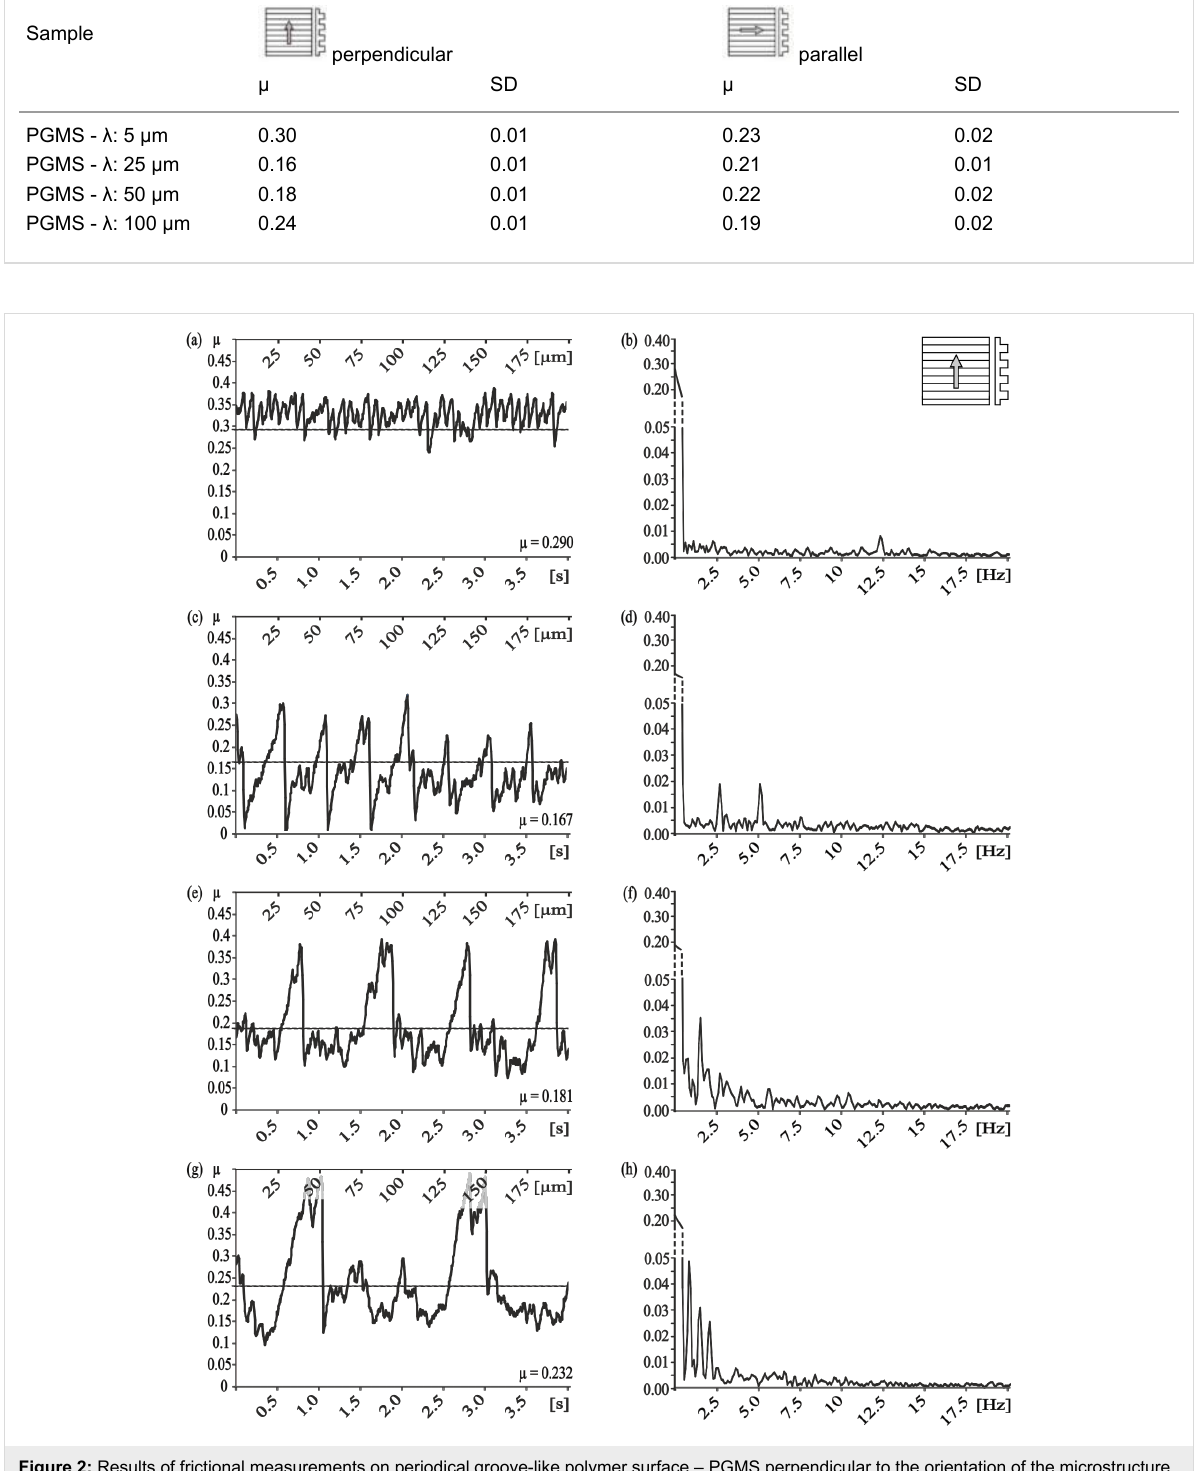
Figure 2: Results of frictional measurements on periodical groove-like polymer surface – PGMS perpendicular to the orientation of the microstructure. Left column, frictional signal in the spatial/time domain. Right column, frictional signal in the frequency domain after FFT; the ordinate shows the single-sided amplitude spectrum – SSAS. PGMS pitch dimension: a,b) 5 µm, c,d) 25 µm, e,f) 50 µm and g,h) 100